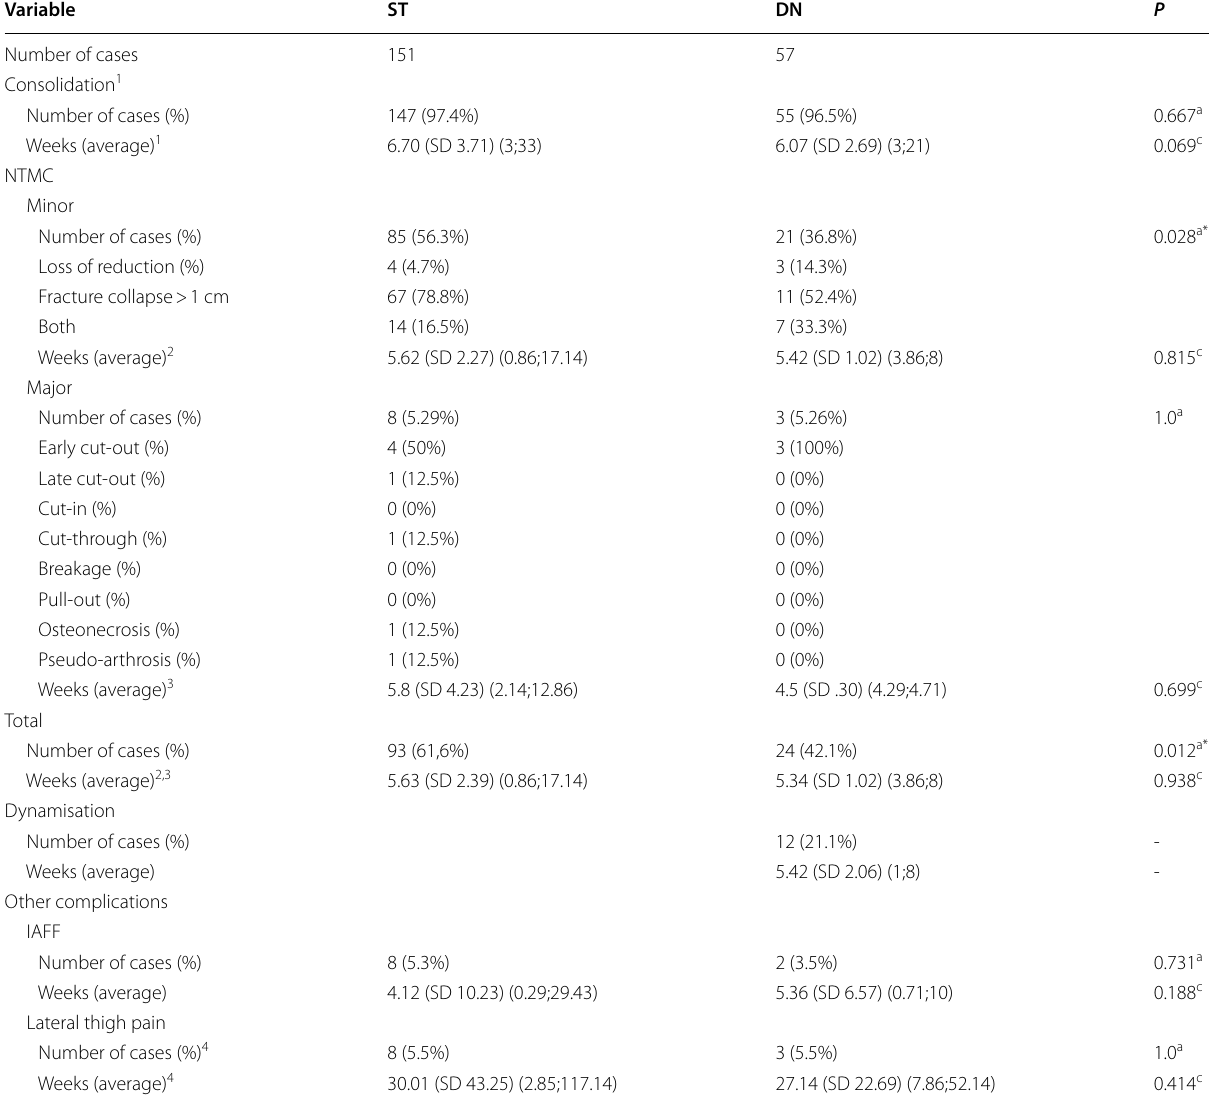
Table 3 Consolidation and post‑operative complications